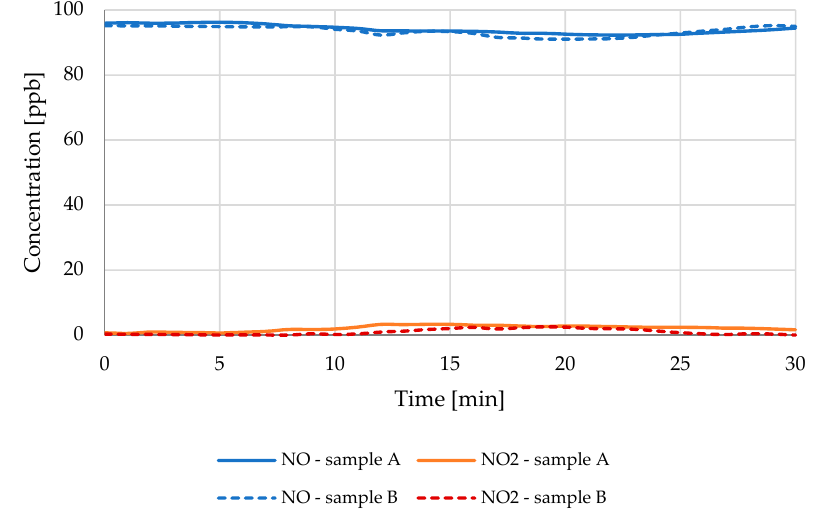
Figure 5. Concentration of nitrogen oxides (NO x ) over time (dusty samples, 70 W light source).